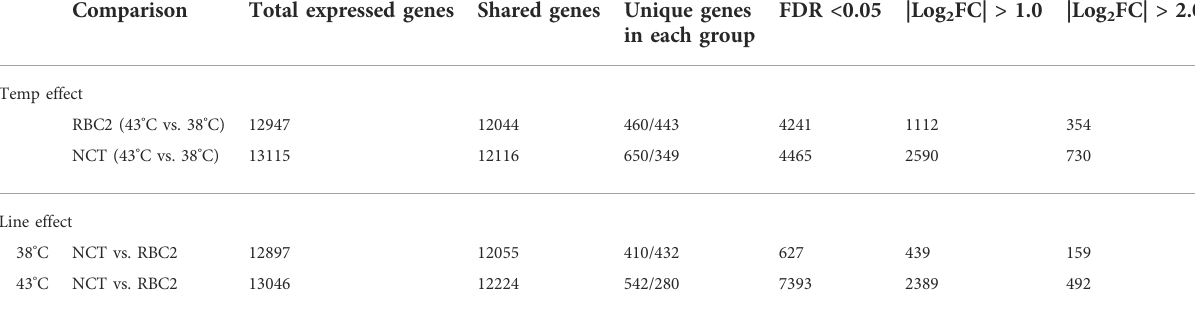
TABLE 2 Summary of gene expression and signi fi cant differential expression (DE) in pair-wise comparisons of proliferating cells. Comparison